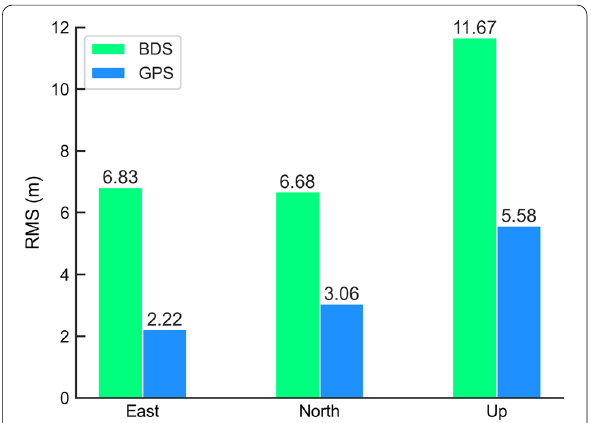
Fig. 23 Kinematic smartphone positioning bias RMS of BDS and GPS in the semi-open